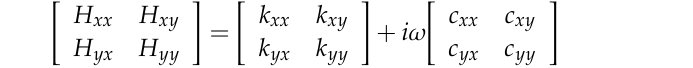
Figure 3. Test cell displacement and acceleration sensor positions.